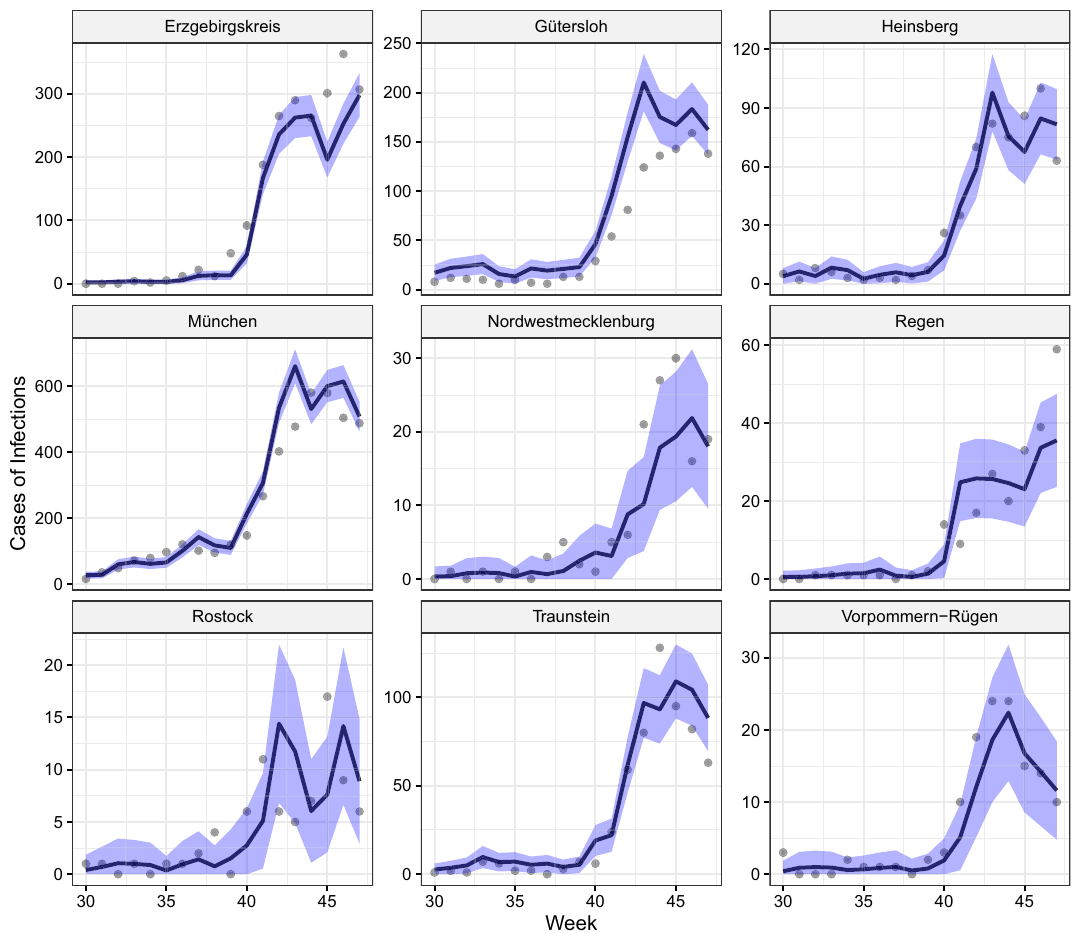
Figure 9. Prediction intervals for age group 35–59 and gender female and selected districts (facets) in Germany. For the different forecast weeks (x-axis) the true number of infections are visualized by points and contrasted with the model’s prediction (black line) and the prediction interval (shaded purple